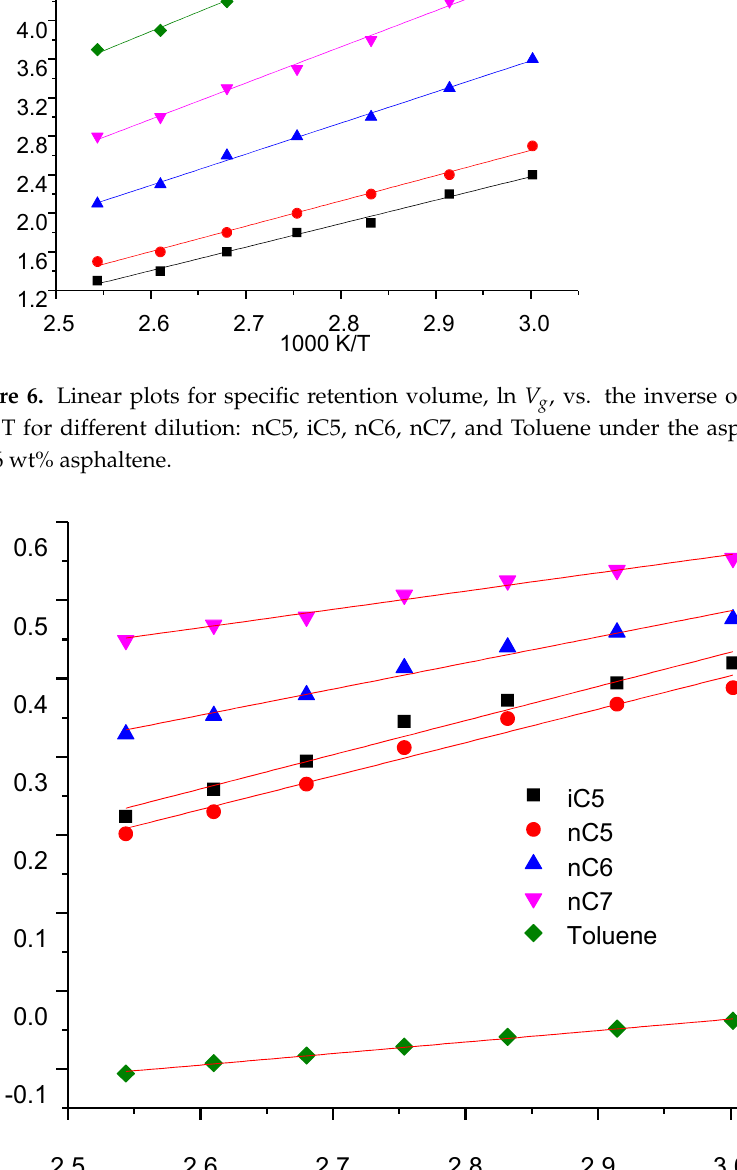
Figure 7. Linear plots for activity coefficients, ln r, vs. the inverse of absolute temperature T: iC5, nC5, nC6, nC7, and Toluene.